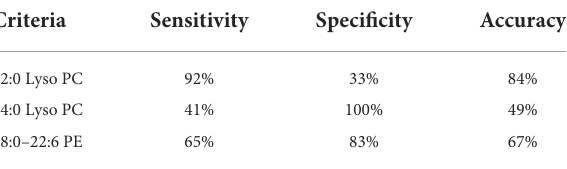
TABLE 3 Sensitivity and specificity of five lipid molecules in the RN group (rotator cuff tear with normal routine serum lipid test). Criteria Sensitivity Specificity Accuracy